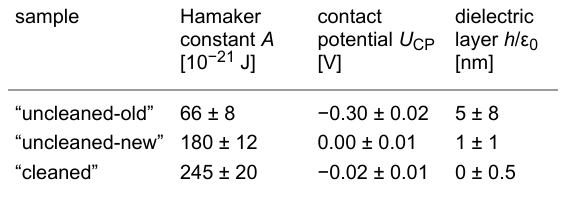
Table 1: Hamaker constant, contact potential and thickness of the dielectric layer obtained by processing interaction images on three samples with different contamination